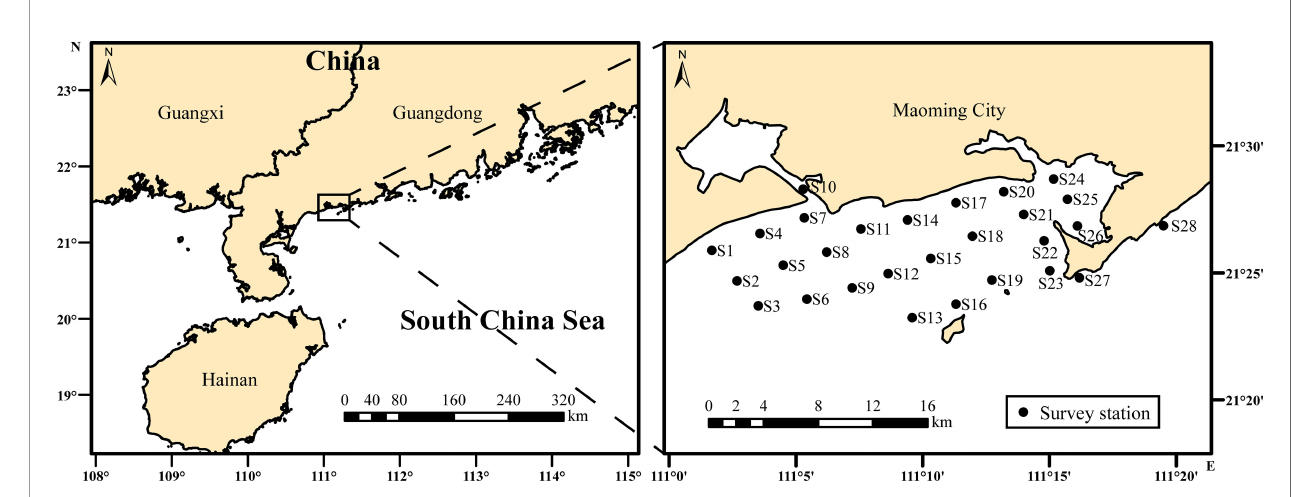
FIGURE 2 | Sampling stations of bivalves in Maoming shallow waters, northern South China